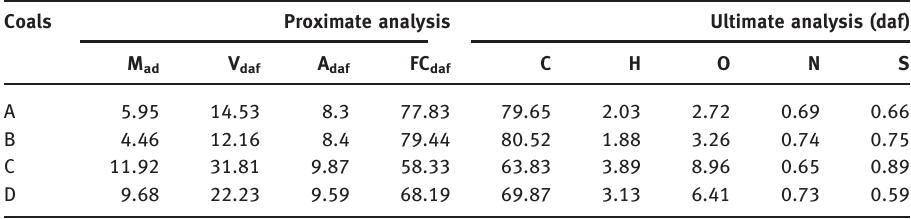
Table 1: Proximate analysis and ultimate analysis of coals (%) . Coals